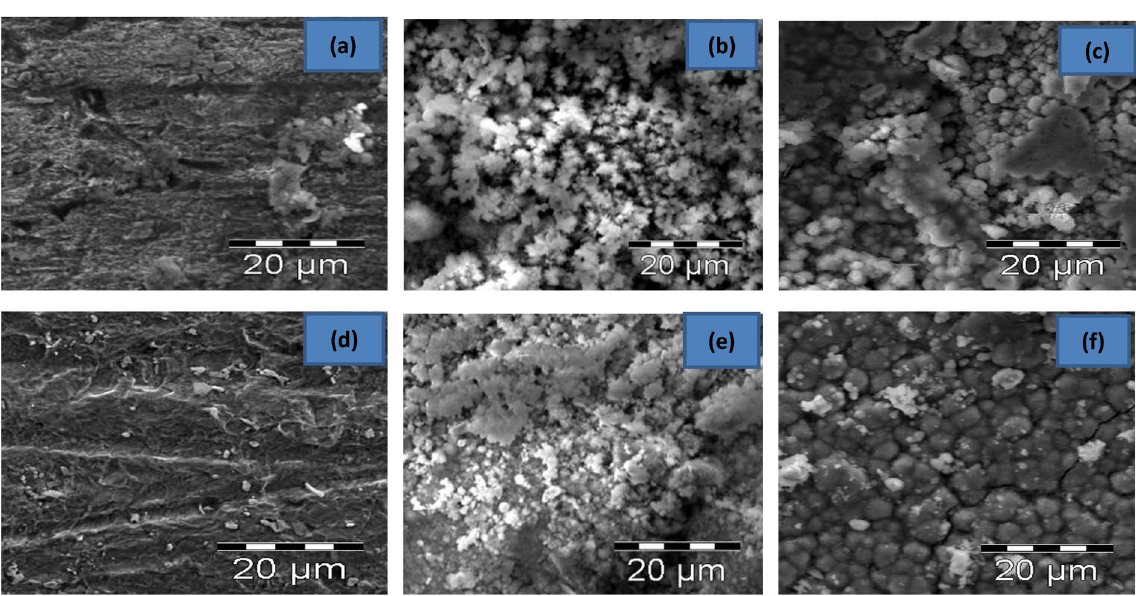
Figure 8. SEM images of mild steel surfaces immersed in SRB culture without and with 100 ppm of the studied inhibitors ( a ) blank ( b ) CZ ( c ) THCZ ( d ) HCZ ( e ) EHCZDCA ( f )